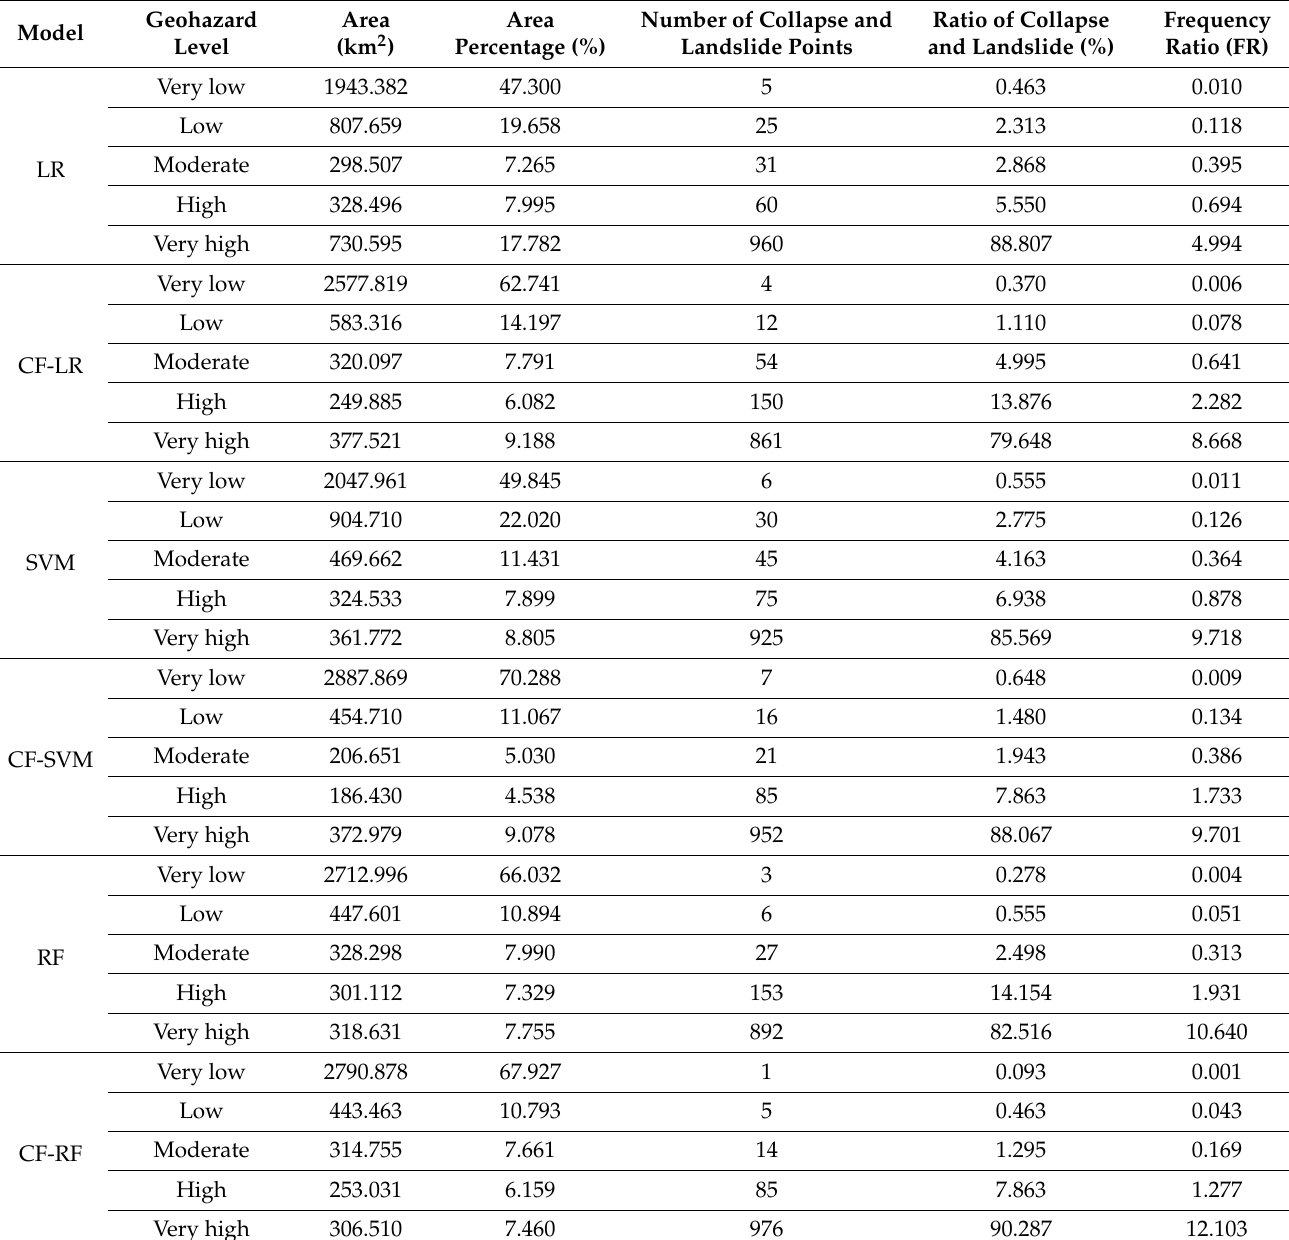
Table 8. Distribution of collapses and landslides at all susceptibility levels with different